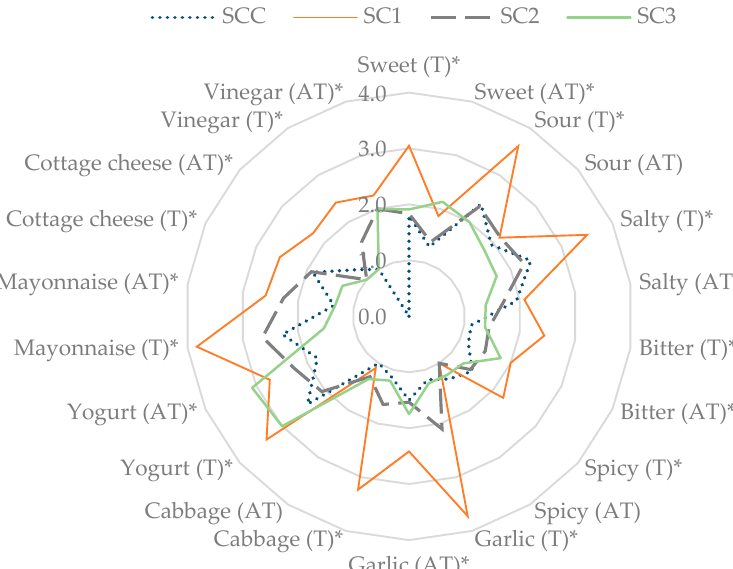
Figure 3. Sensory attributes of taste (T) and aftertaste (AT) of the salt and equivalent salt of sauerkraut juice powder in the samples with sour cream. * These tastes and aftertastes represent significant differences ( p ≤ 0.05).